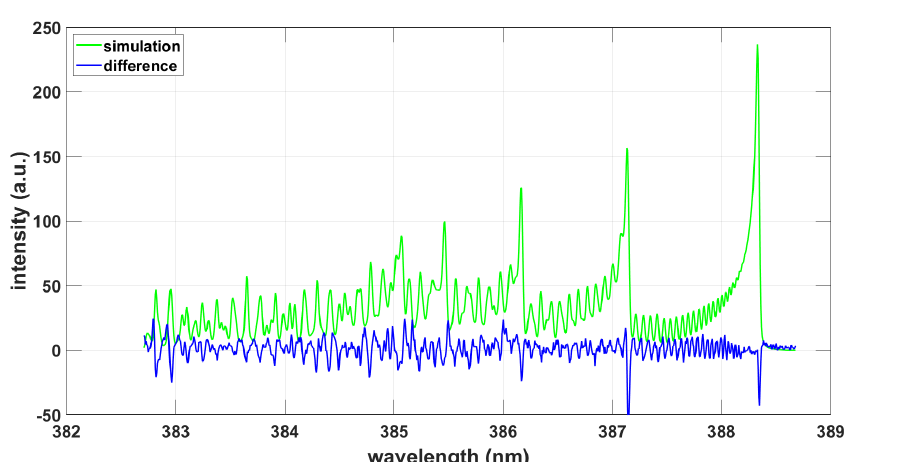
Figure 5. Simulation using LIFBASE with fixed T = 8103 K, ∆ λ = 0.033 nm, Voigt profile with 30% Lorentzian